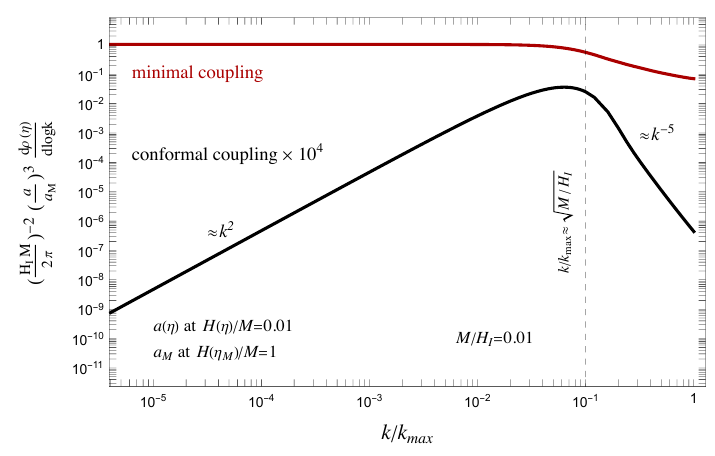
Figure 1 . Energy density per unit logarithmic mode a 4 dρ/d log k of eq. (3.3), normalized to ( H 2 π ) 2 aa 3 . The plot shows the energy of real scalars of mass M conformally (black) and I M/ M minimallly (red) coupled. The spectrum is for M/H